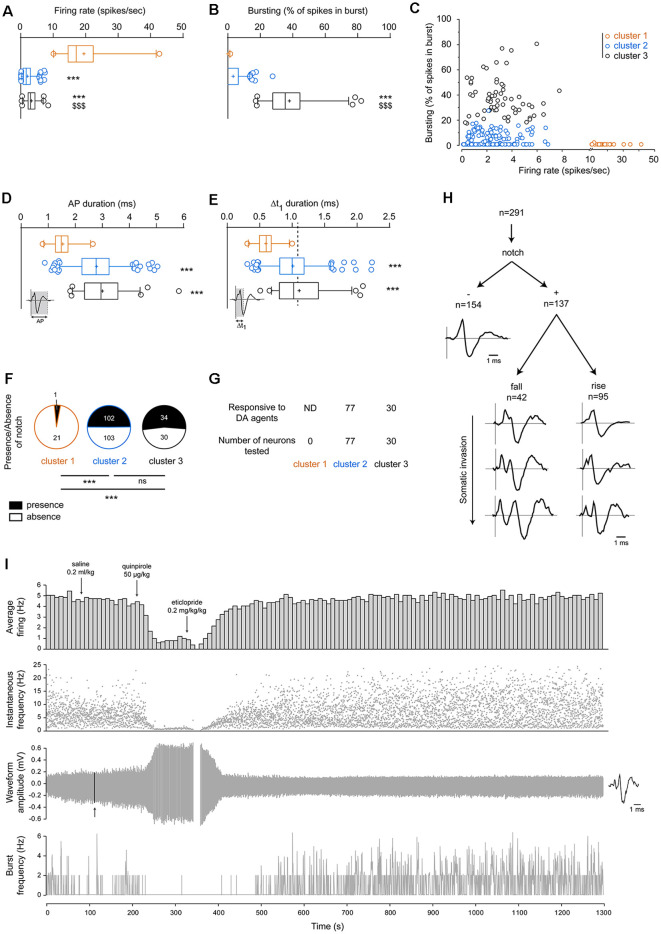
Segregation of VTA neuronal populations according to their electrophysiological properties. (A) Firing rates are significantly higher in cluster 1 than clusters 2 and 3. Neurons from cluster 2 displayed significantly lower firing rates than neurons from cluster 3. (B) Neurons from cluster 3 displayed significantly greater bursting activities than neurons from either cluster 2 or 3. (C) Firing rates and bursting activities in neurons from each cluster. High-firing neurons belonging to cluster 1 presented very minimal bursting activities. Generally, neurons belonging to cluster 3 (n = 64) presented burst activities above 17.5% of all spikes in bursts, while neurons belonging to cluster 2 (n = 205) displayed burst activities below 17.5%. Here, these three clusters are segregated. (D) Total action potential (AP) durations are significantly lower in the high-firing neurons (cluster 1) than in neurons from cluster 2 or 3. (E) Similarly, Δt1 durations from cluster 1 were significantly lower than cluster 2 or 3. The dashed line represents the well-established cut-off criterion to distinguish between DA and non-DA neurons at 1.1 ms (Ungless and Grace, 2012). (F) Presence/absence of notched AP waveforms in neurons belonging to clusters 1, 2, or 3. Statistical results were performed using Chi-square tests. (G) Neurons responsive to DA pharmacology (apomorphine 10–70 μg/kg, quinpirole 20–60 μg/kg or methylphenidate 2–4 mg/kg) were found in both cluster 2 and 3. Note that some neurons were not tested. (H) Within all neurons included in the present study (n = 291), great heterogeneity of AP waveforms was observed. One-way Kruskal–Wallis analysis of variance (ANOVA) results are given as following: ***p < 0.001 vs. cluster 1 and $$$p < 0.001 vs. cluster 2. (I) Typical recording example of VTA neurons where the dopamine D2 receptor agonist quinpirole (50 μg/kg, iv) induces autoreceptor-mediated negative feedback, which is reversed by the dopamine D2 receptor antagonist eticlopride (0.2 mg/kg, iv). Note that quinpirole greatly increased the AP amplitude. The arrow indicates the location of the AP waveform represented on the right. All of the histograms represented here are box-plots (box and whiskers). The “+” sign represents the mean. The horizontal bar represents the median value. The interquartile range (Q1–Q3) is displayed with a vertical rectangle (“box”), while the thin lines (“whiskers”) represent the intervals between the lowest/highest values and the Q1/Q3 quartiles, respectively. Outlying values are represented individually with open circles but were not excluded from all analyses. Asterisks (***) are used to indicate significantly different values vs. cluster 1, while dollars ($$$) are used to indicate significantly different values vs. cluster 2. ns: non-significant.